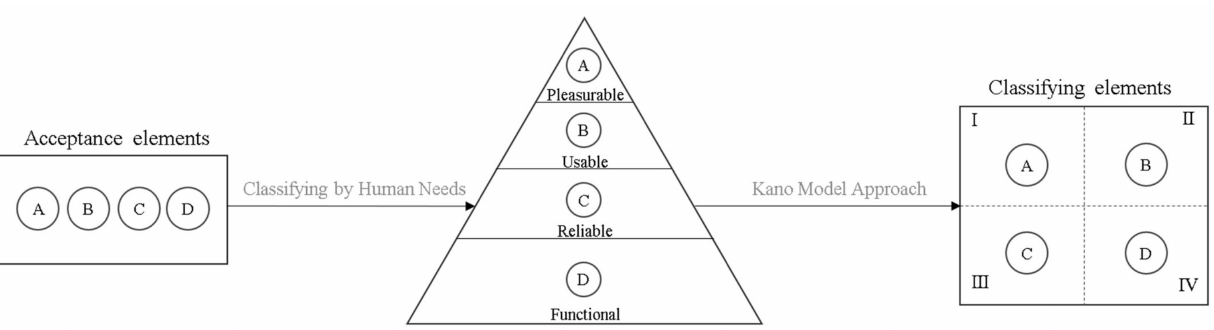
Figure 3. Study framework derived from the Kano